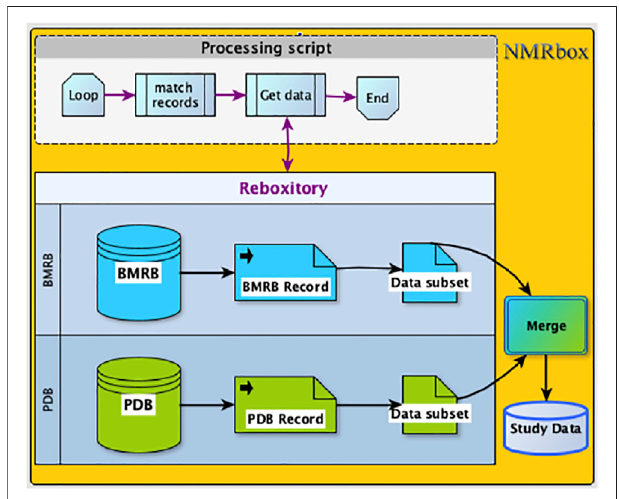
FIGURE 6 | The Processing script and the data are co-located on the NMRbox platform. Access (read), as well data merge (write) operations are managed in a manner that is, similar to the way local fi les are